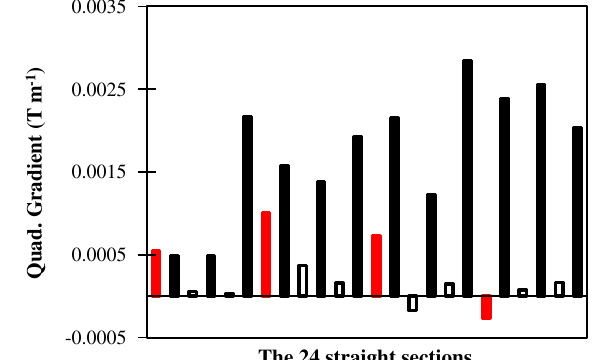
FIG. 3. Measured tune shifts due to a single in-vacuum ID (closed to minimum gap) versus beam current in 4 = 4 filling: black, horizontal; white, vertical; dotted lines, linear fittings.